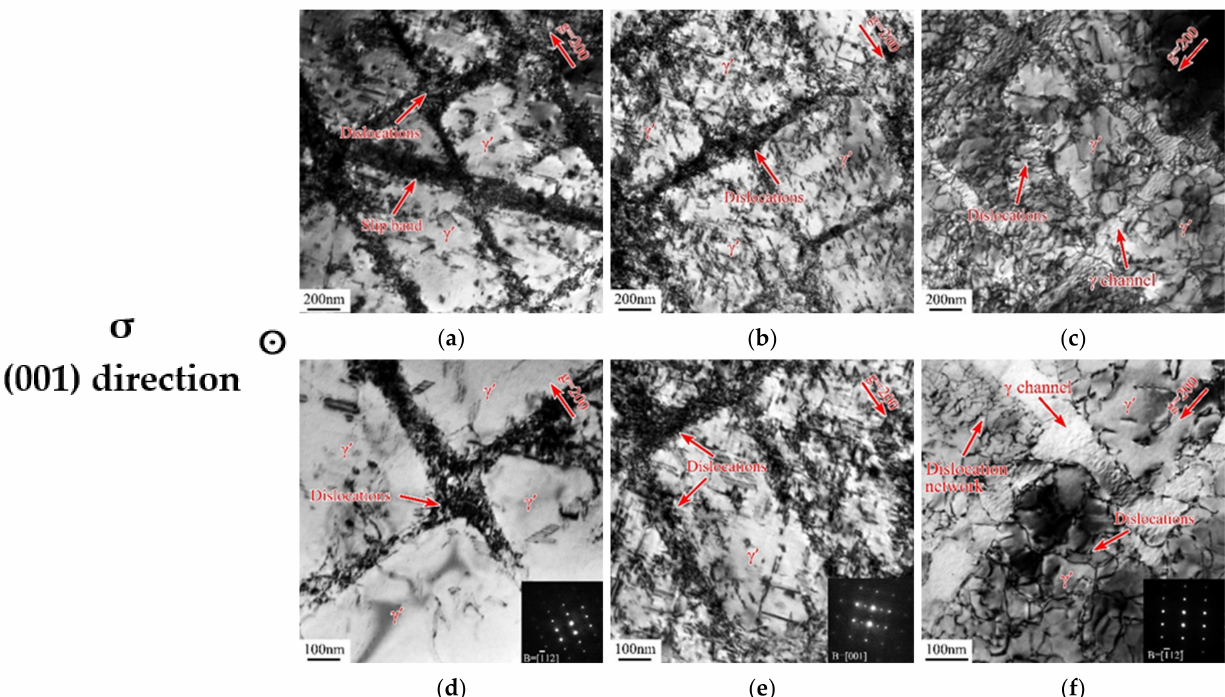
Figure 7. TEM images of typical dislocation configurations in the dendrite cores at the cross sections close to the fracture surface of DZ406 superalloy at a lower and higher magnification when tested at − 125 ◦ C ( a , d ), 25 ◦ C ( b , e ) and 1000 ◦ C ( c , f